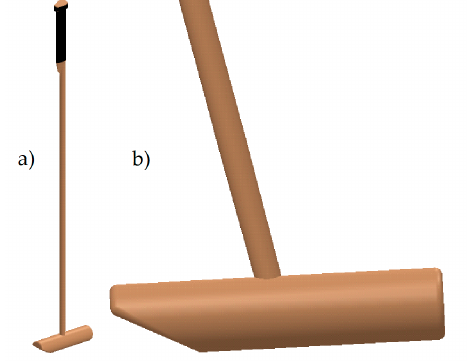
Figure 1. CAD models of the polo mallet. ( a ) The full shaft with handle and head and ( b ) the head used to strike the ball during